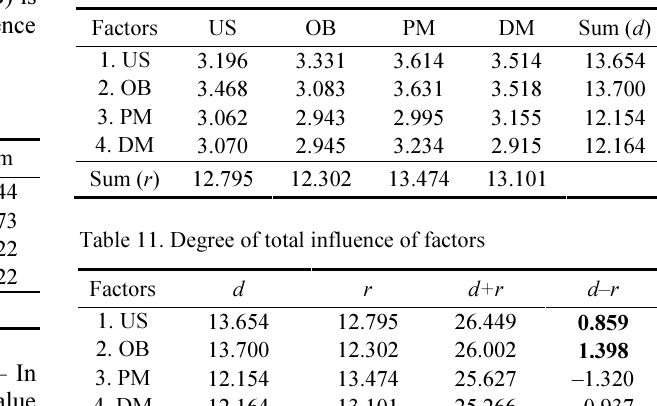
Table 10. Total influence matrix T of factors